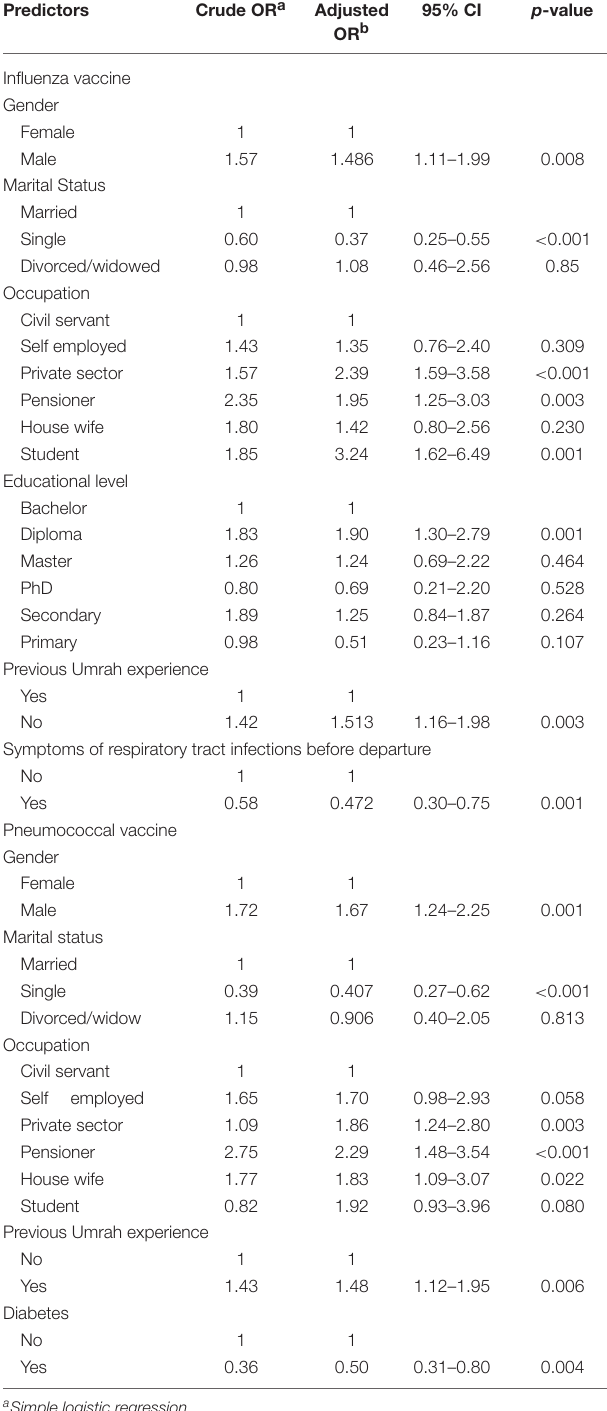
TABLE 2 | Significant factors associated with vaccines uptake among Malaysian Hajj/Umrah pilgrims.